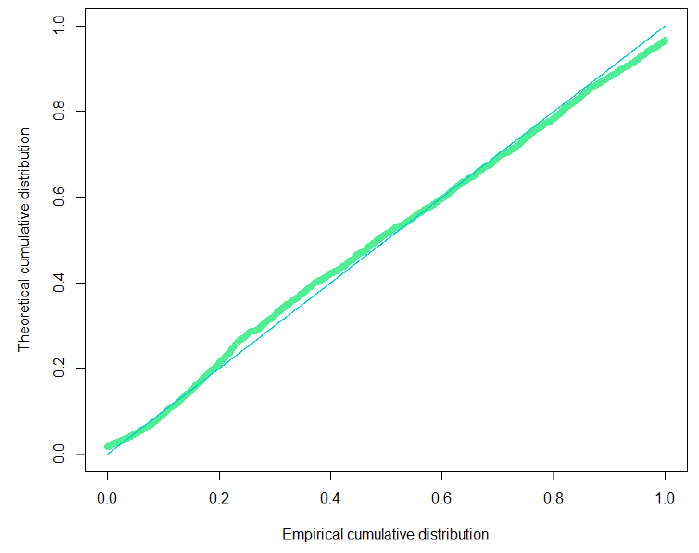
Figure 4. P-P plot of gamma-Lindley